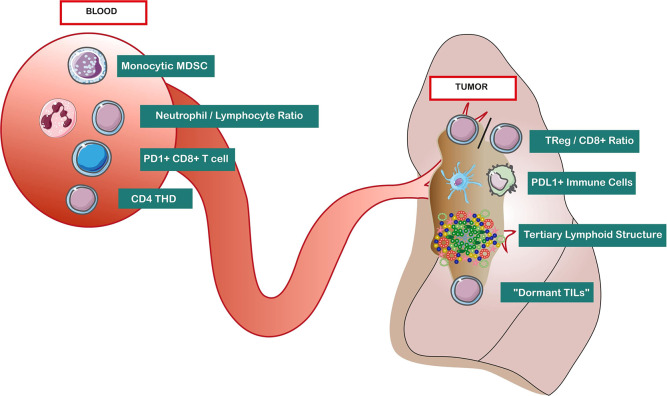
Baseline immune predictors of response to lung cancer medical treatments, in blood and tumor microenvironment. “Dormant TIL” is defined as CD3high granzyme Blow Ki-67low. Abbreviations: CD4 THD, highly differentiated CD4+ T cells (CD27– CD28low/−); Mo-MDSC, monocytic myeloid-derived suppressor cells; PDL-1, programmed death ligand 1; TIME, tumor immune microenvironment; TReg, regulatory T cells.